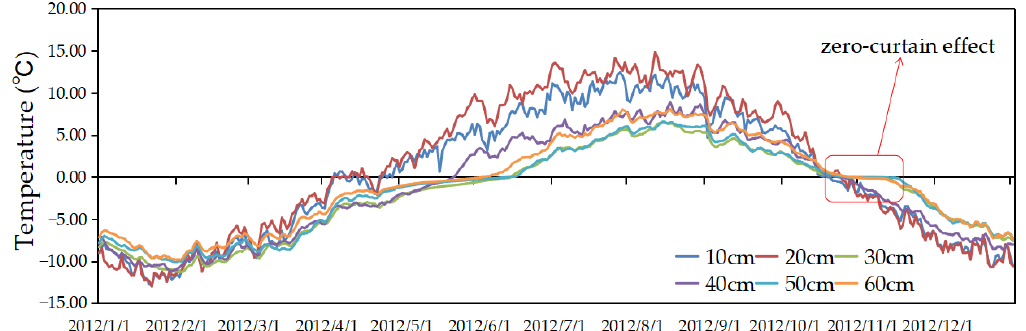
Figure 12. Temporal changes of the mean subsurface temperatures at the depths of 10, 20, 30, 40, 50 and 60 cm in 2012, obtained by the TLZ